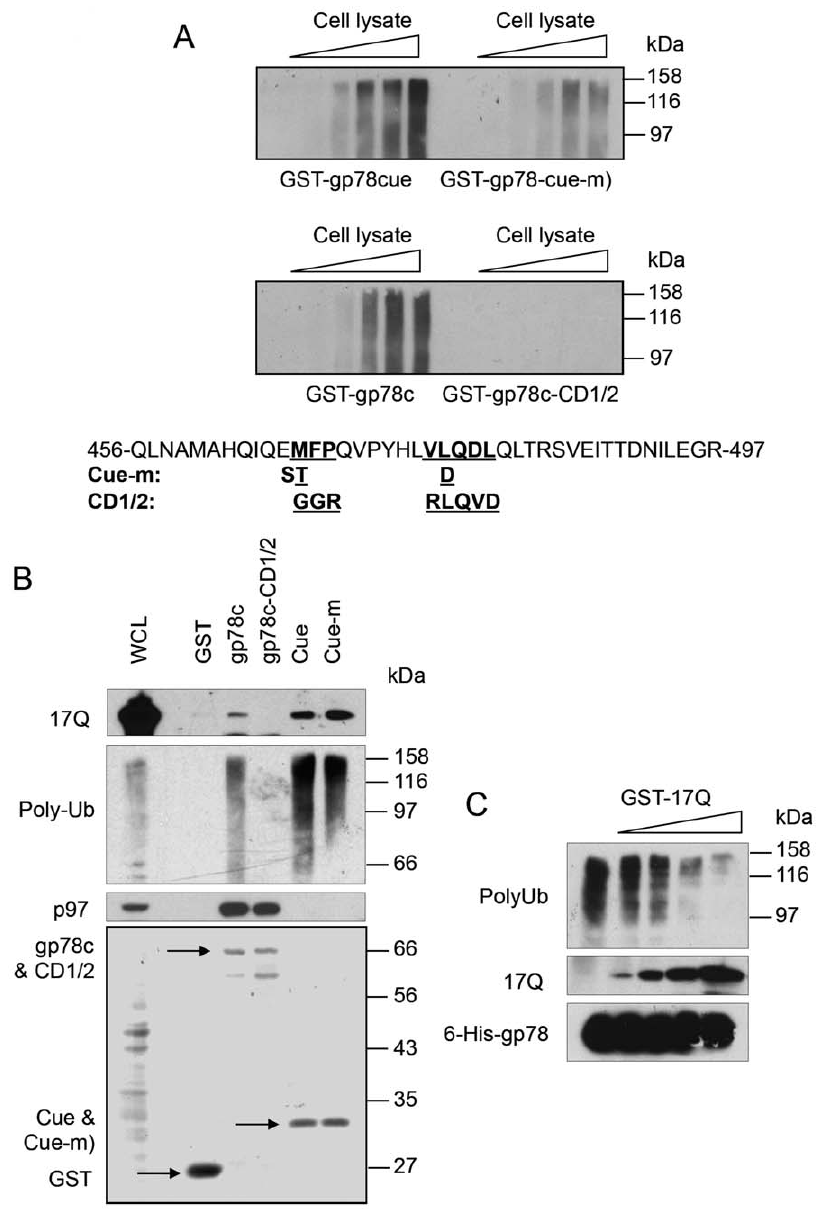
Figure 5. Htt588 inhibits polyubiquitinated protein binding to gp78. A. Effects of cue domain mutation on polyubiquitin binding. GST fusions of two different cue domain mutants: cue-m and gp78cCD1/2(aa309-643), and their corresponding wt controls, cue and gp78c(aa309–643), were immobilized on beads and incubated with increasing amounts of lysates prepared from HEK293 cells. After washing, polyubiquitinated proteins associated with these GST fusion proteins were examined by immunoblotting for ubiquitin. B. gp78c-CD1/2 fails to bind both Nhtt17Q and polyubiquitin. GST fusion proteins as indicated were incubated with HEK293 cell lysates prepared from HEK293 cells transfected with Nhtt17Q. Polyubiuitinated proteins and Nhtt17Q were detected by immunoblotting. C. Nhtt17Q dose-dependent inhibition of polyubiquitinated protein binding to 6-His-gp78c. Beads-immobilized 6-His-gp78c was incubated with HEK293 cell lysates or along with increasing amounts of purified GST- Nhtt17Q. After washing, beads-associated polyubiquitin and GST-Nhtt17Q were determined by